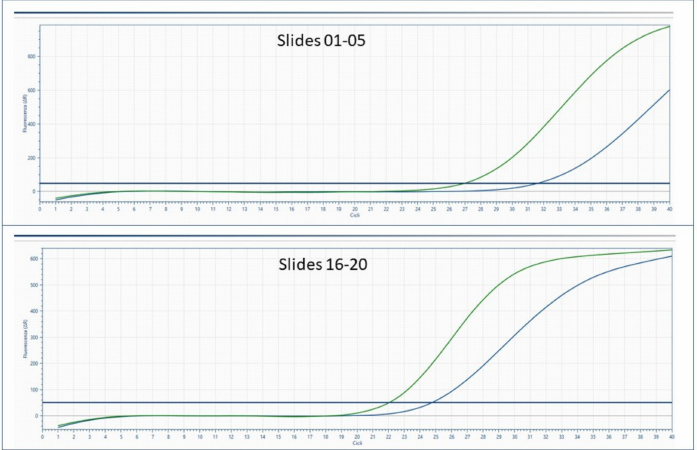
Figure 3. EasyPGX results for MET exon 14 skipping molecular alteration detected in processed slide